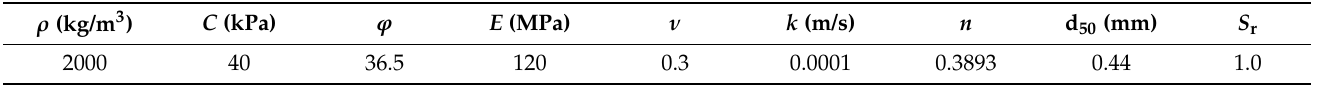
Table 3. Physical property parameters of seabed foundation soil.